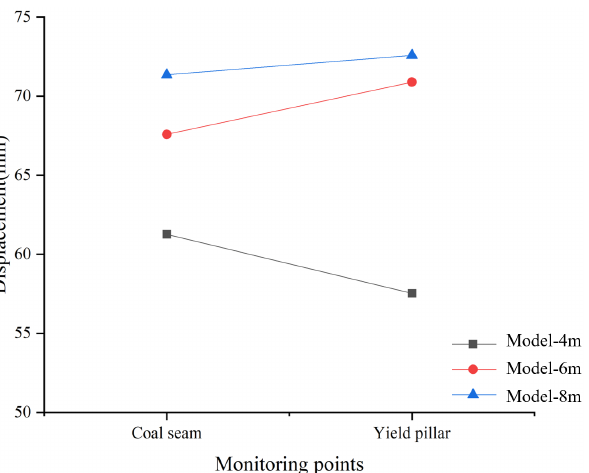
Figure 19. Displacement of the two sides of the different yield pillar widths during the excavation.